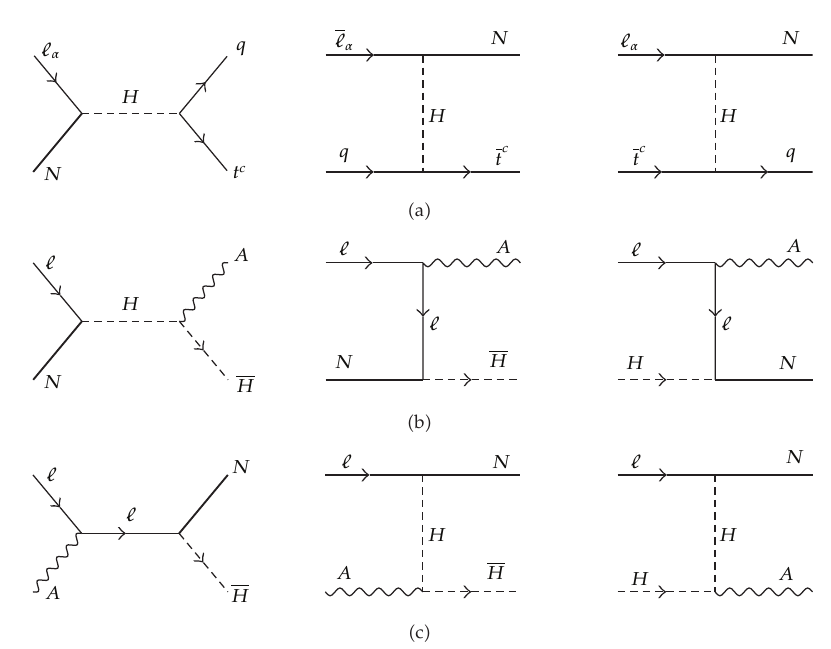
Figure 2: Diagrams for various 2 ↔ 2 scattering processes: (cid:5) a (cid:6) scatterings with the top quarks; (cid:5) b (cid:6) and (cid:5) c (cid:6) scatterings with the gauge bosons (cid:5) A (cid:7) B , W i with i (cid:7) 1 , 2 , 3 (cid:6)